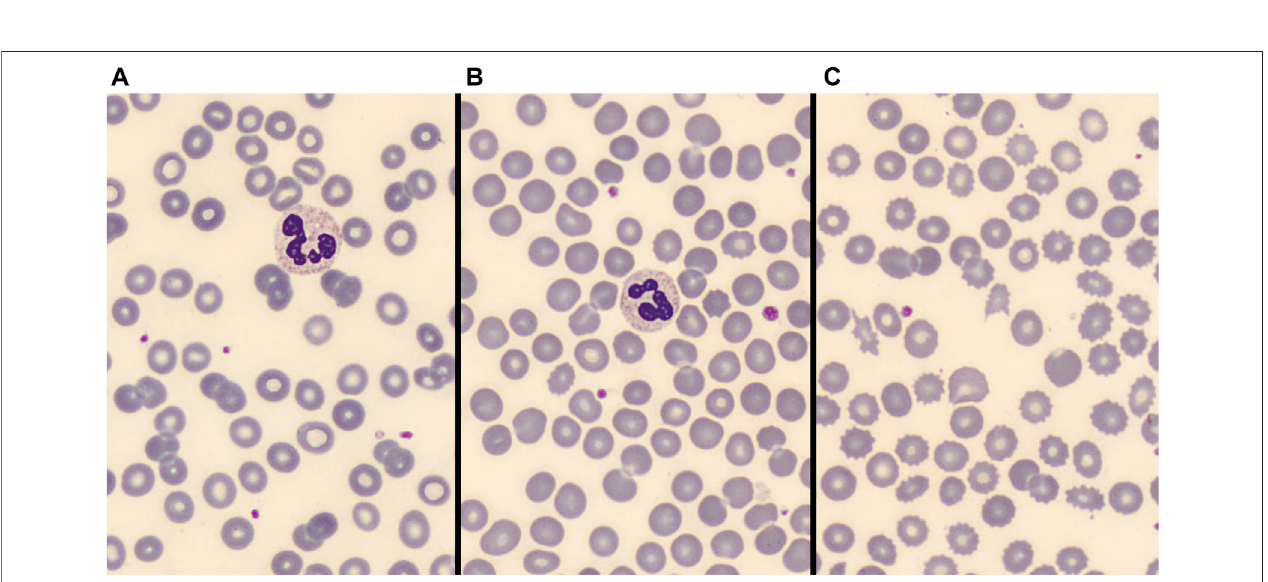
Frontiers in Physiology |